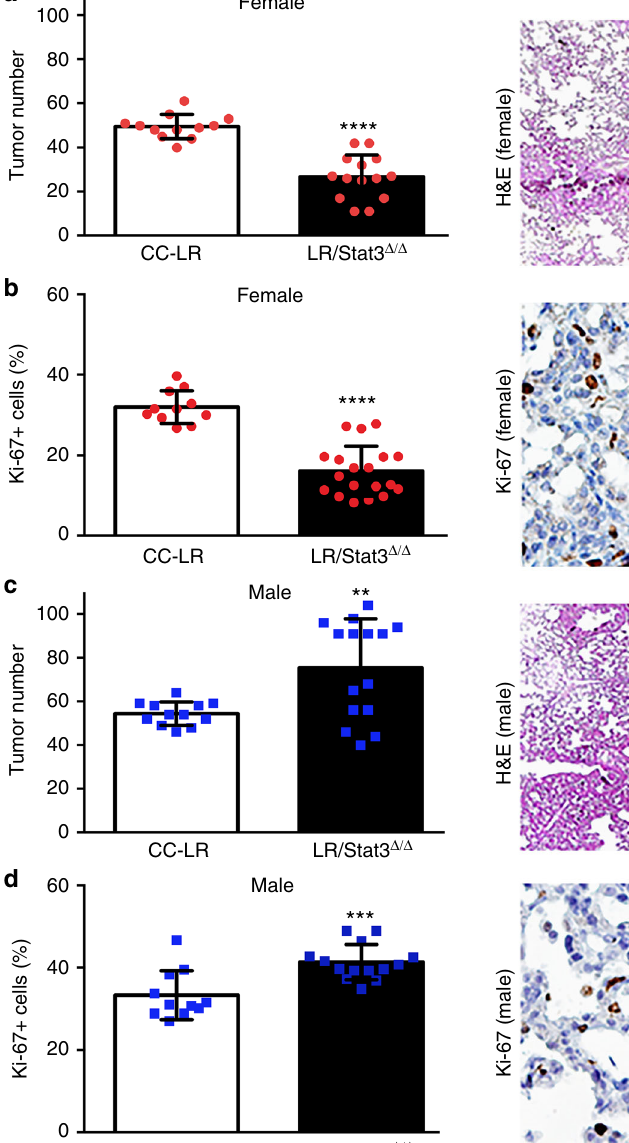
Table 3). Gene set enrichment analysis also revealed predicted activation of T-cell receptor (TCR) signaling ( z -score = 2.6; P = 0.003 of the Fisher ’ s test) following epithelial Stat3 deletion in female CC-LR mice with the opposite pattern (inhibition of TCR signaling; z -core = − 2.0) occurring in male LR/ Stat3 Δ / Δ litter- mates (Supplementary Table 3). Of note, further analysis linking differential gene expression and aberrant biological functions revealed a modulation of various gene sets overall pointing to marked dampening of the host anti-tumor immune response (e.g. gene sets associated with leukocyte migration) following Stat3 deletion in male CC-LR mice (Fig. 2b, Supplementary Data 2). In